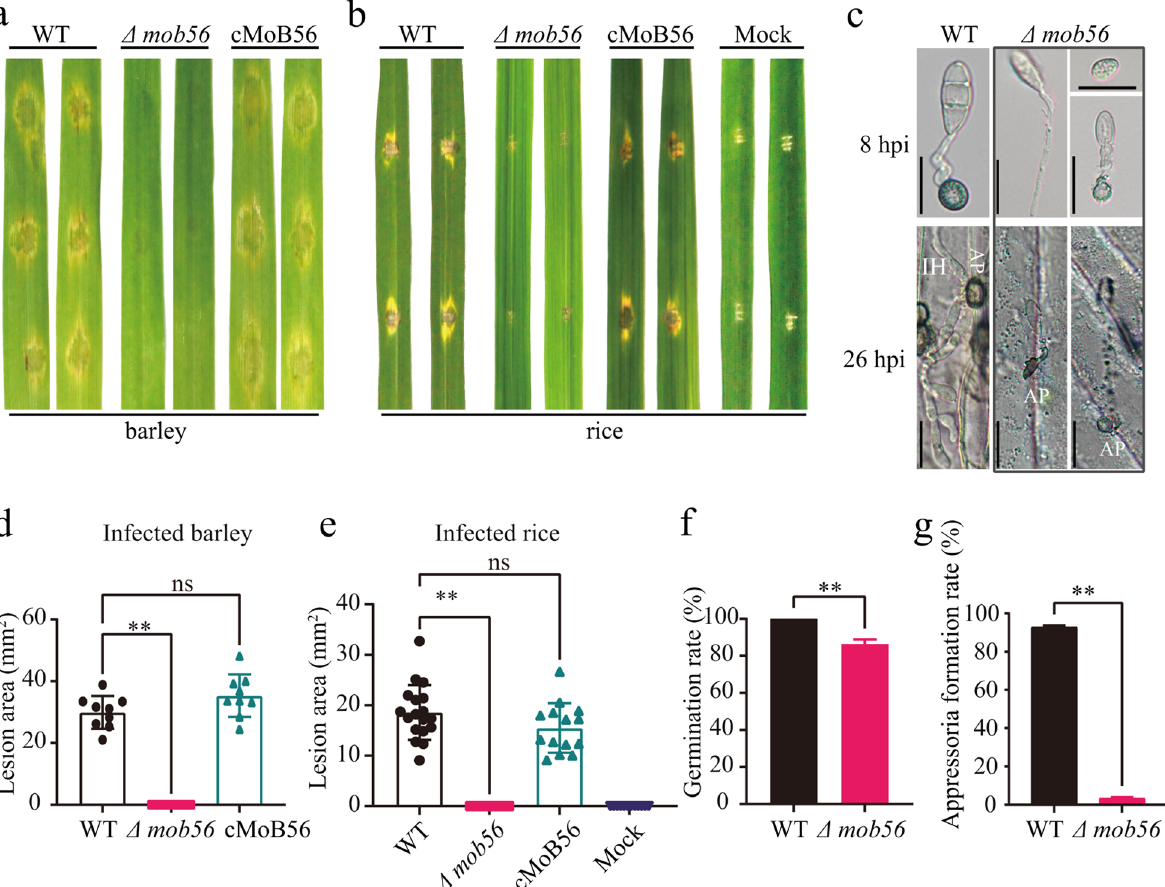
Fig. 4 MoB56 is essential to the pathogenicity of Magnaporthe oryzae . a Pathogenicity test on unwounded barley leaves. One‑week‑old barley seedlings were inoculated with conidial suspensions of WT, the Δmob56 mutant and its complemented strain cMoB56. Photographs were taken at 5 days post‑inoculation (dpi). b Pathogenicity test on wounded rice leaves. Detached rice leaves of four‑week‑old rice seedlings were inoculated with the mycelia of the indicated strains. Photographs were taken at 5 dpi. c The infection‑related development process observation of the indicated strains on hydrophobic coverslips at 8 h post‑inoculation (hpi) and on barley epidermal cells at 26 hpi. Bars 20 μm. d Statistical analysis of each = lesion area on barley leaves. Error bars represent SD. **, P < 0.01. e Statistical analysis of each lesion area on wounded rice seedling leaves. Error ± bars represent SD. **, P < 0.01. f Statistical analysis of germination rate of the indicated strains on hydrophobic coverslips after 8 hpi. Error bars ± represent SD. **, P < 0.01. g Statistical analysis of appressorium formation rate of the indicated strains on hydrophobic coverslips after 12 hpi. Error ± bars represent SD. **, P < ±